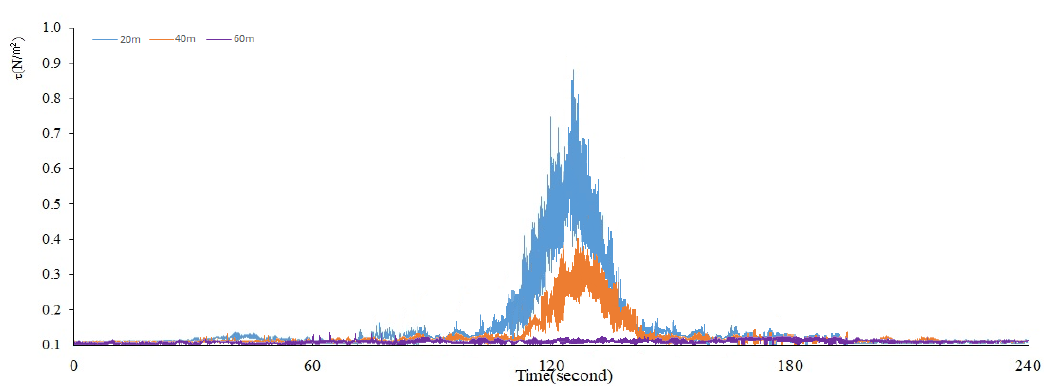
Figure 6. Changing trends of the maximum total shear stress ( τ ) under a full load.